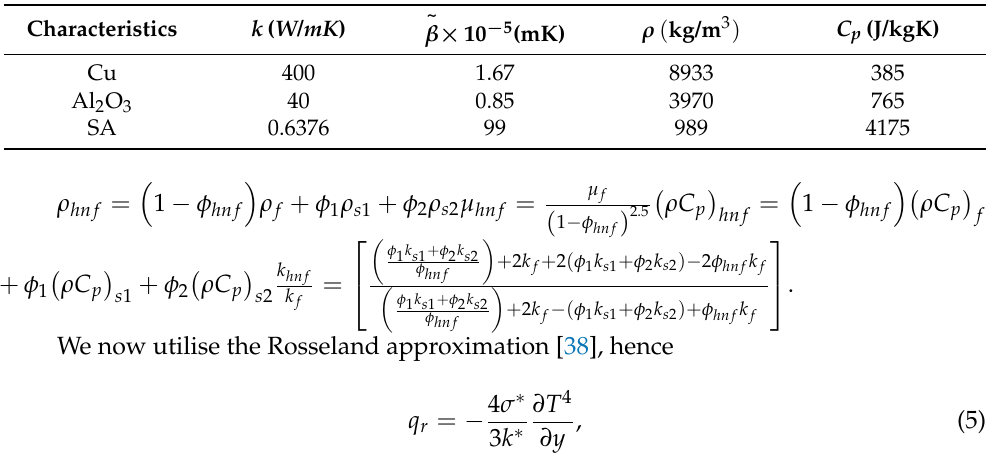
Table 2. The nanoparticles and base fluid properties